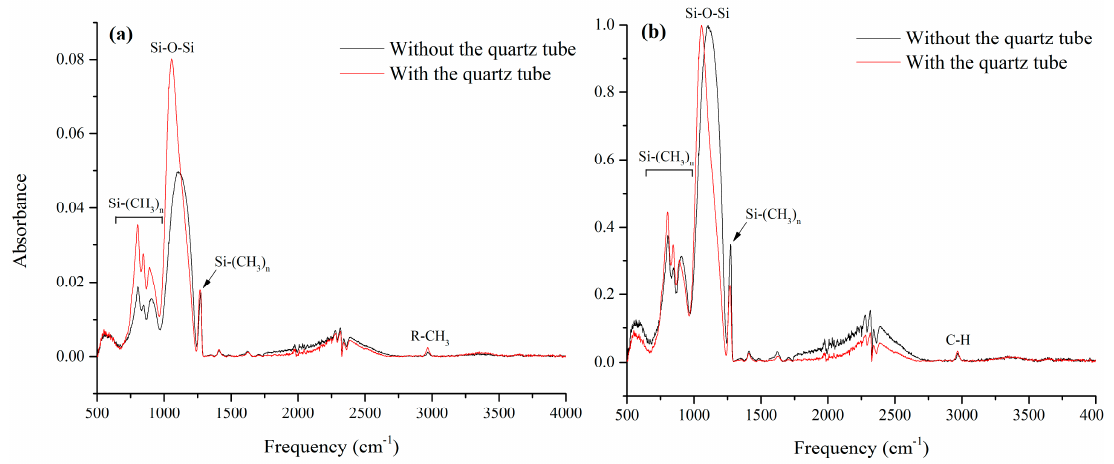
Figure 5. ( a ) Fourier transform infrared spectroscopy (FTIR) spectra of samples prepared with PT5 conditions, with and without the quartz tube surrounding the jet. ( b ) shows the same spectra normalized according to Si-O-Si band.